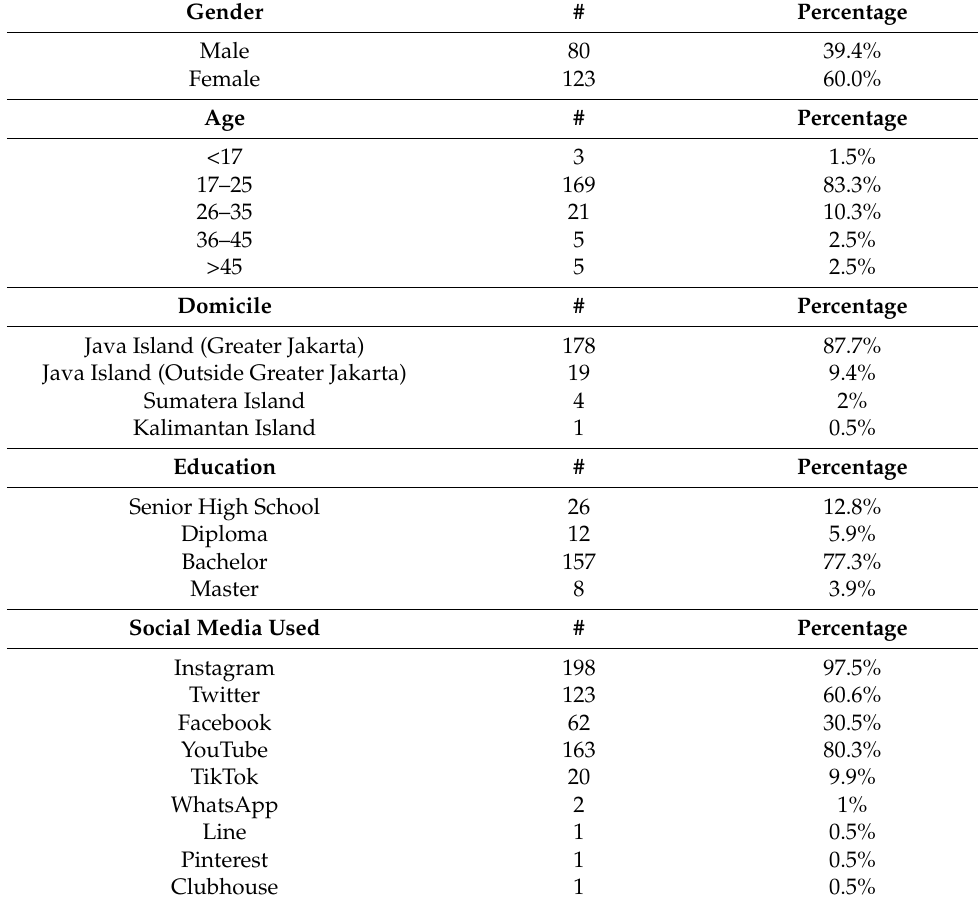
Table 2. Respondent demographic data.